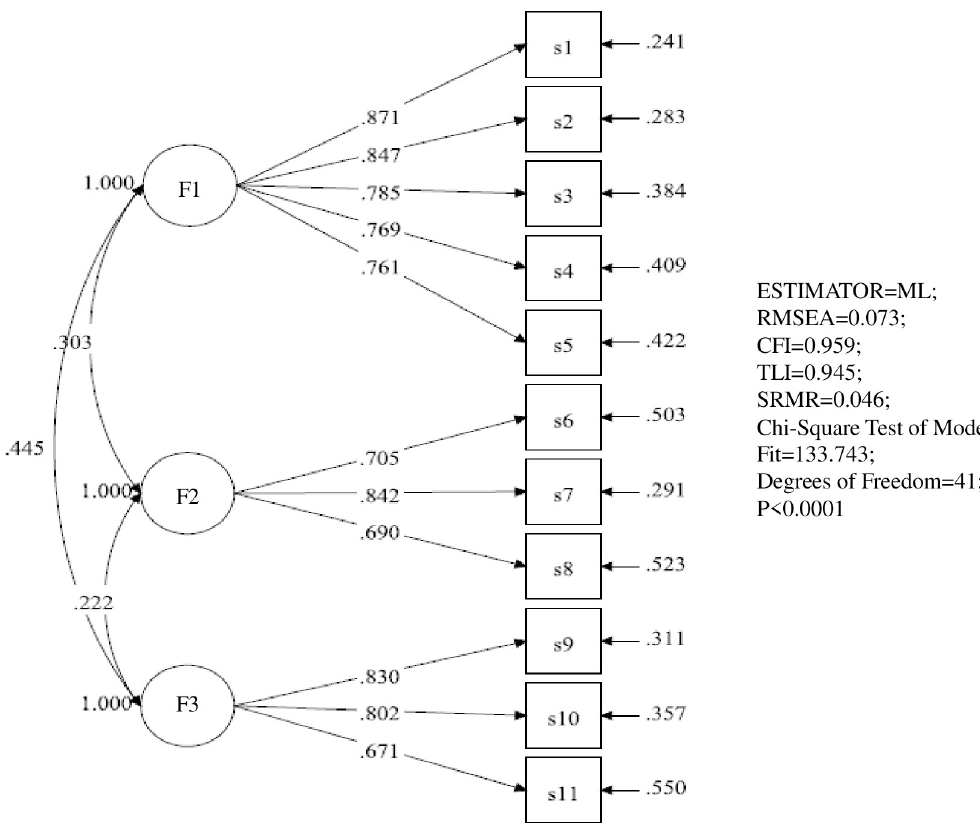
Fig 1. Confirmatory factor analysis of the Chinese version of SE-PMC. F1: Promoting Oral Hygiene; F2: Providing Mouth care; F3: Obtaining Cooperation.